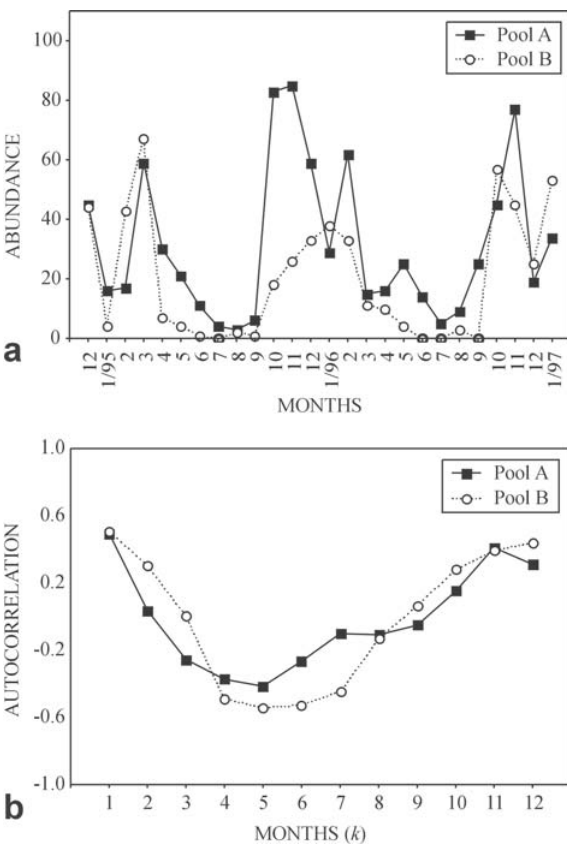
Fig. 4. Temporal variability (a) and correlogram of total abun- dance (b) of fish recorded in the experimental fish ladder (Pool A = 10 m, Pool B = 27 m) located near Itaipu Dam.